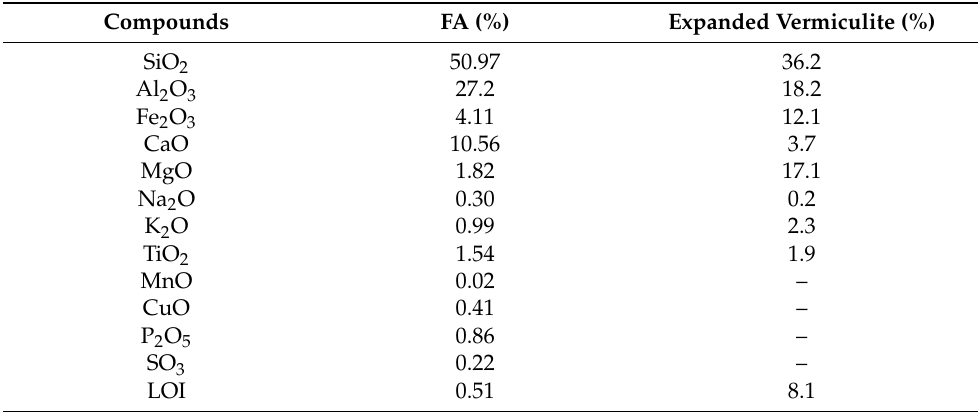
Table 1. Chemical compositions of FA and expanded Table 4. Mix proportions of geopolymer mortar.